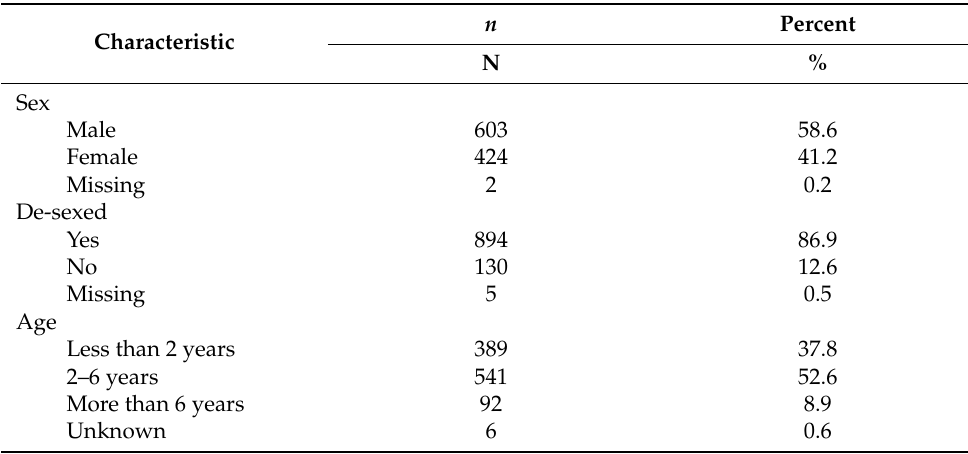
Table 1. Summary statistics for characteristics of 1029